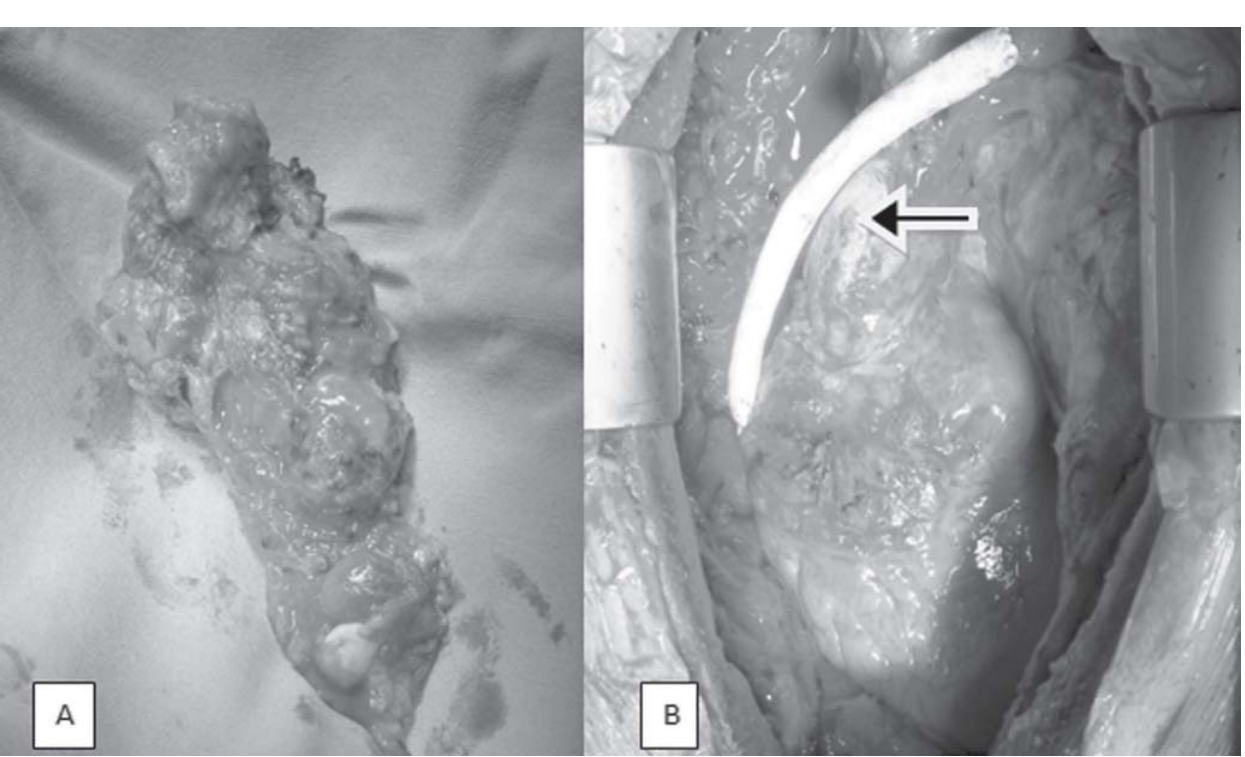
Fig. 2 - Na imagem A, está representada aparência macroscópica do tumor após retirada em bloco com os vasos envolvidos. Na imagem B, a seta indica a derivação venosa, veia subclávia esquerda e átrio direito realizada com tubo de PTFE 8